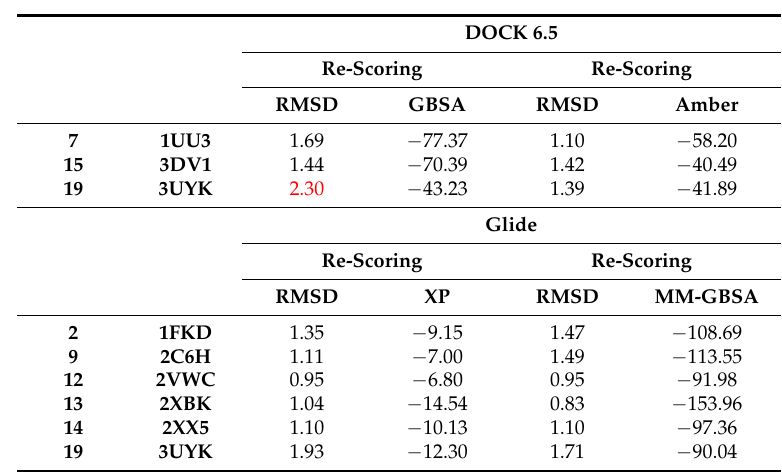
Table 6. Re-scoring of DOCK and